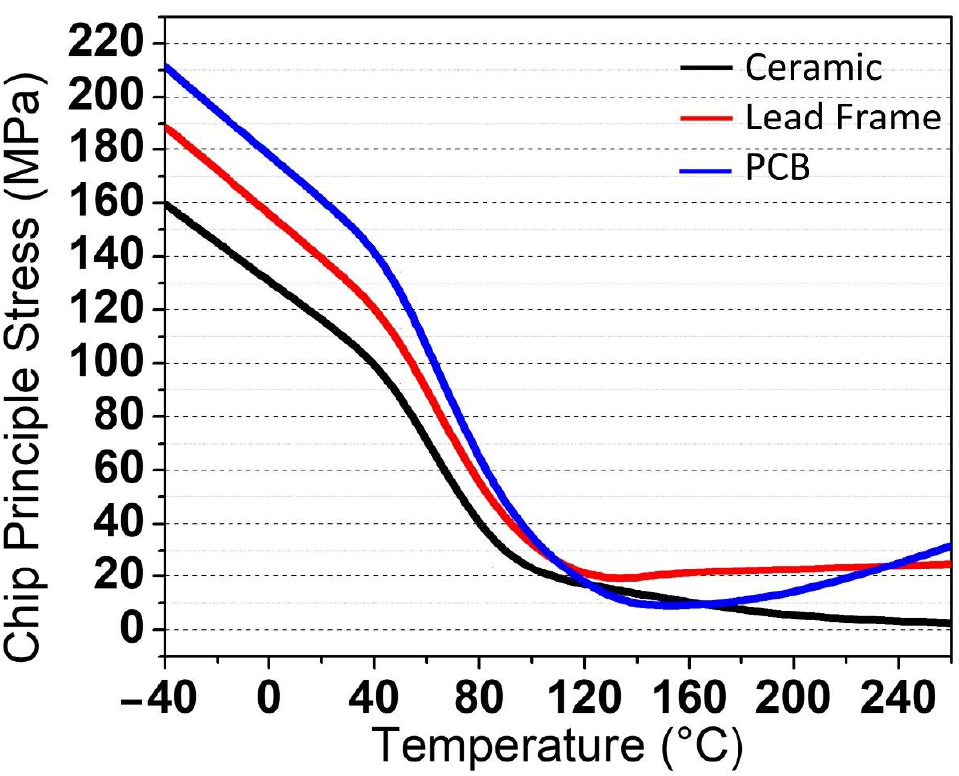
Figure 11. Chip surface stress values versus temperatures ranging from − 40 °C to 260 °C during the mechanical stress simulation.